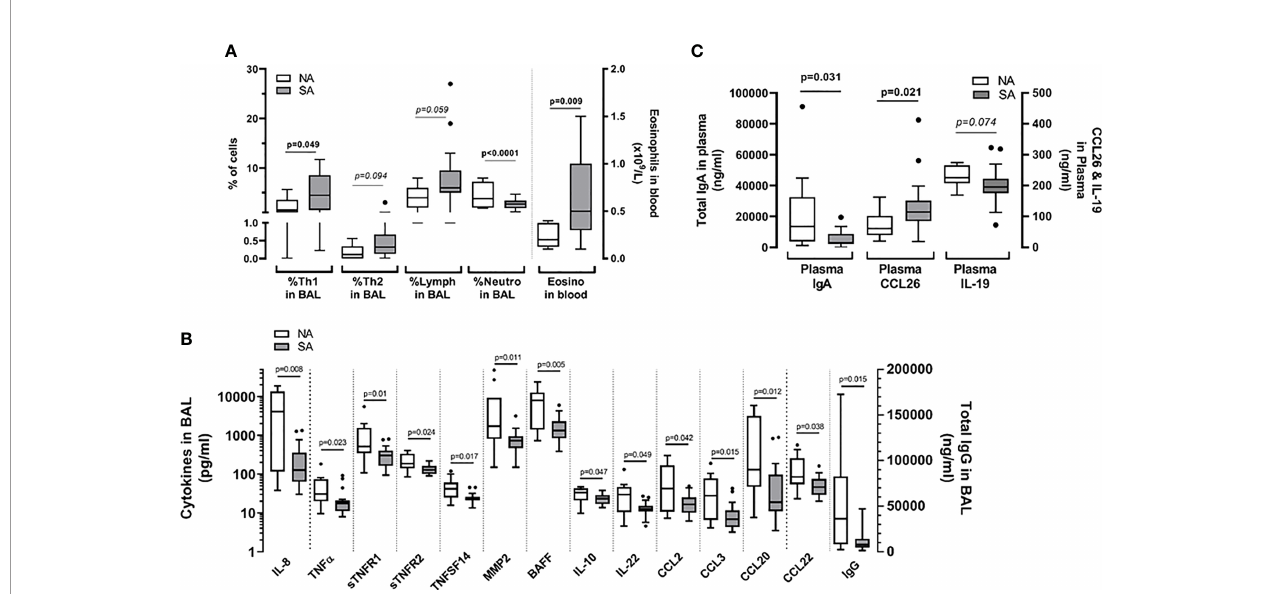
FIGURE 3 | Discriminant immune constituents (VIP > 1) that show signi fi cant (p < 0.05) differences or trends towards (0.05 < p < 0.1, indicated in italics) differences between children with SA (grey bars) and NA controls (clear bars). (A) Cellular immune constituents. (B) Cytokines and IgG concentrations in BAL. (C) CCL26, IgA, and IL-19 concentrations in plasma. Exact p values (MW test) are indicated for each